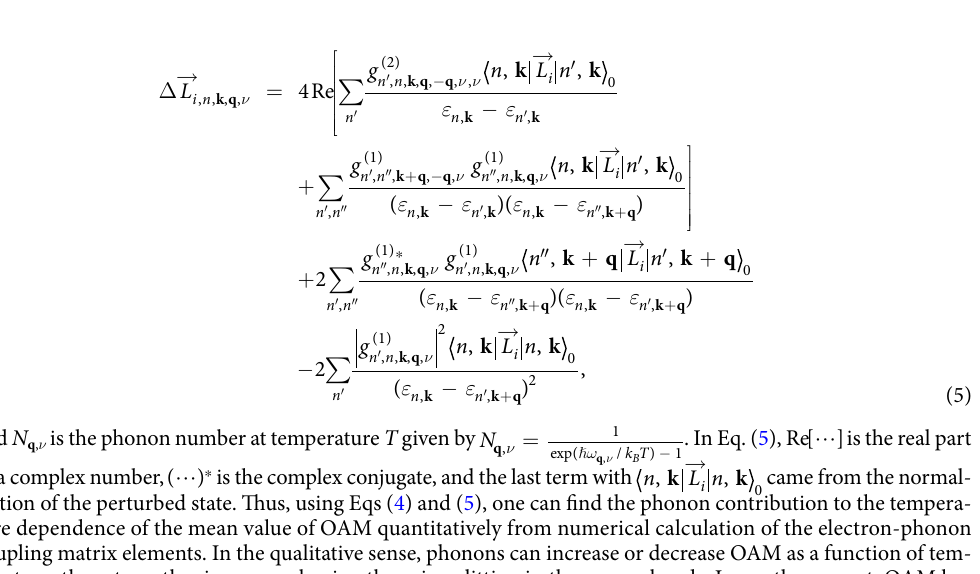
Figure 5. Bulk HgTe. ( a ) Atomic structure. The (110) mirror plane is shaded in yellow. ( b ) Schematic representation of the interatomic hopping between Te p x ′ and p z orbitals in the [110] direction. ( c , d ) The lowest conduction band obtained ( c ) without SOI and ( d ) with SOI. The size of open dots represents | 〈 L y ′ 〉 | obtained without SOI in ( c ) and | 〈 S y ′ 〉 | with SOI in ( d ), with blue for positive and red for negative values. ( e , f ) Constant- energy cut of the lowest conduction band(s) at the energy of 1 eV near Γ obtained ( e ) without SOI and ( f ) with → → SOI. Arrows indicate L obtained without SOI in ( e ) and S with SOI in ( f